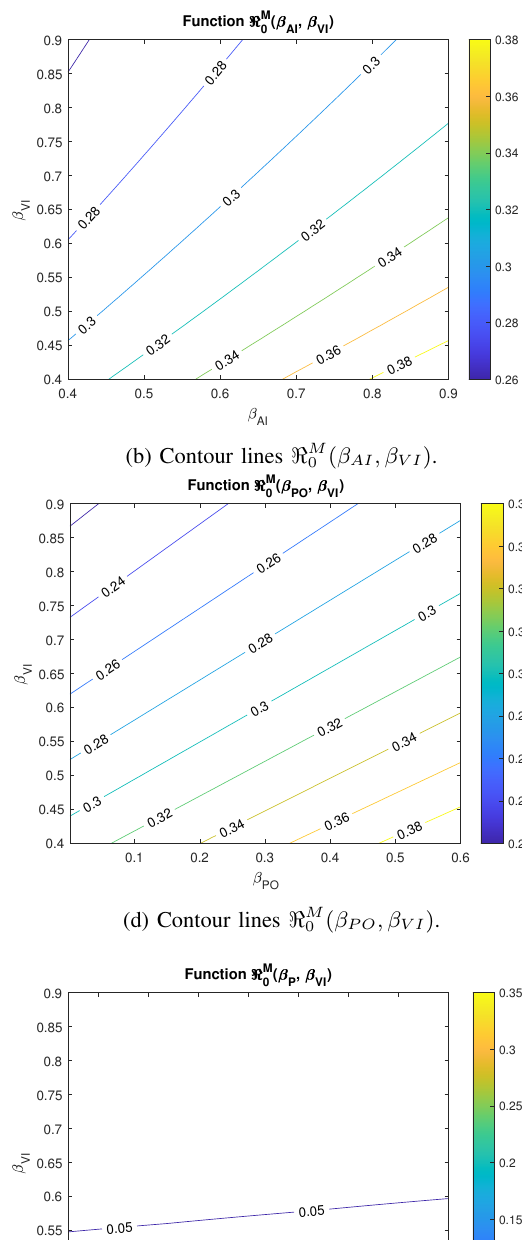
(d) Contour lines (cid:60) M 0 ( β PO , β V I ) .